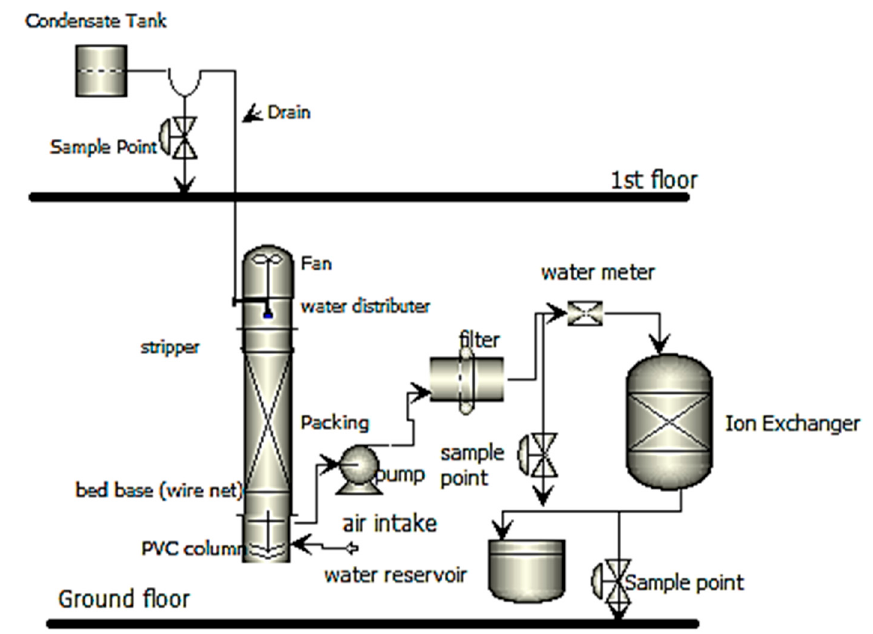
Figure 10. A flowchart for water treatment in the Swedish evaporative gas turbine pilot plant, illustration of water-recovery techniques in humidification-based power units.